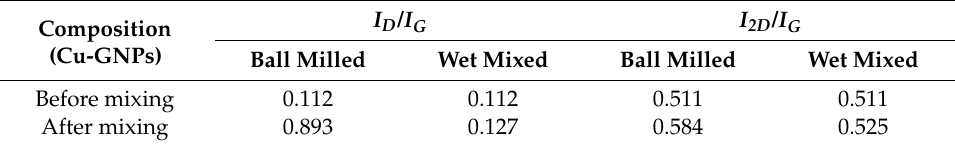
Table 3. Raman data of GNPs before and after wet mixing and ball milling, data from [69]. Composition (Cu ‐ GNPs)